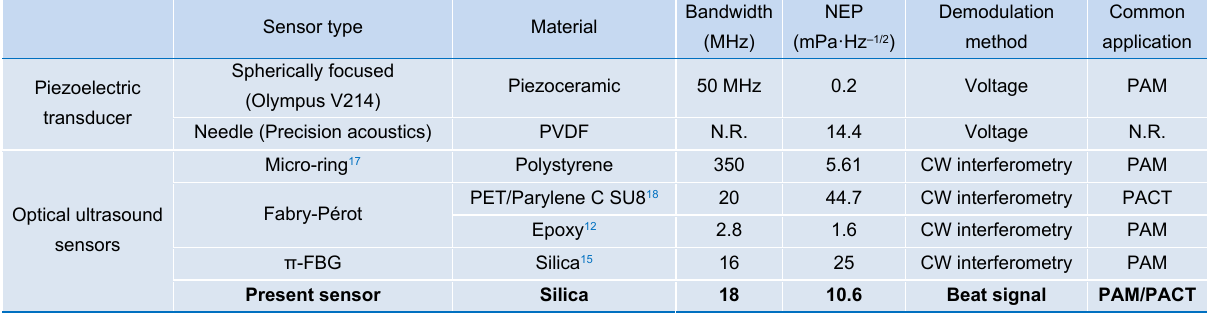
Table 1 | Comparison of piezoelectric and optical ultrasound